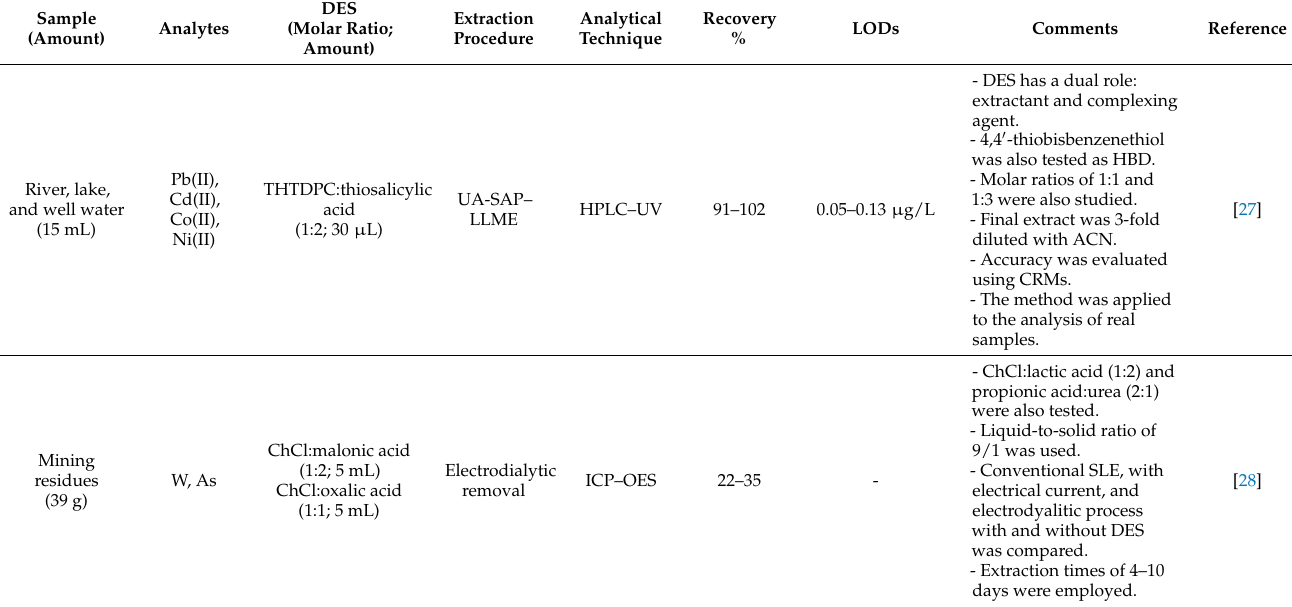
Table 2. Some examples of recent applications of DESs to the analysis of inorganic species in environmental samples. Sample (Amount) Analytes